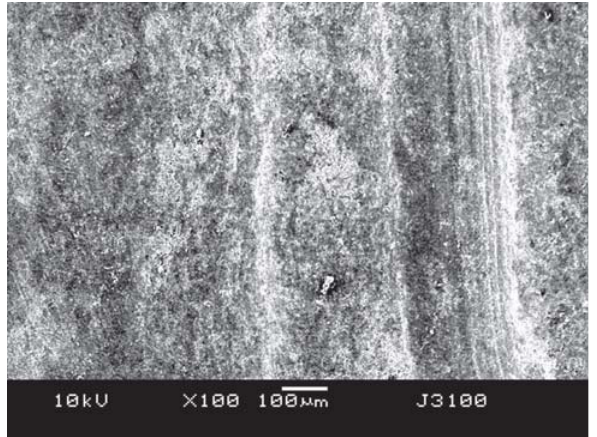
FIGURE 3- Micrograph of root surface instrumented by ultrasonic scaler. Note the rougher surface. Original magnification 100x